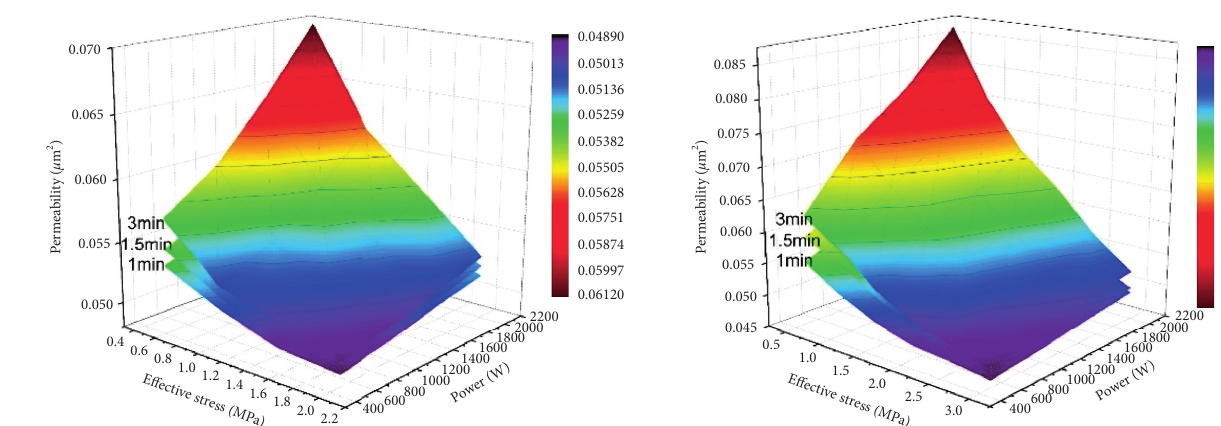
Figure 13: Three-dimensional changes of permeability under axial and confining pressures of 3 MPa.